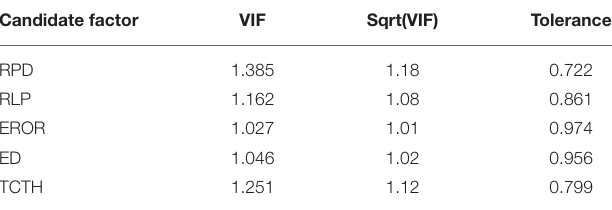
TABLE 2 | The variance inflation factors. TABLE 3 | Estimation Results of the time-dependent MNL